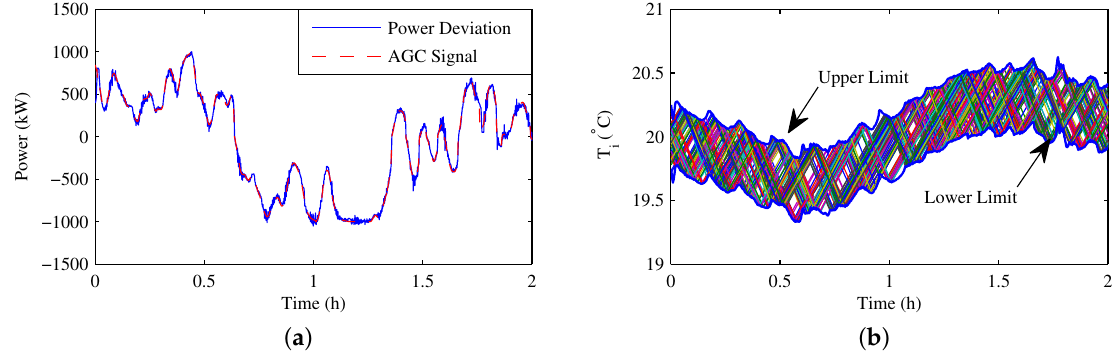
Figure 2. ( a ) AGC signal tracking under the sliding-mode control strategy; ( b ) Temperature distribution of 100 HVAC units (randomly chosen out of